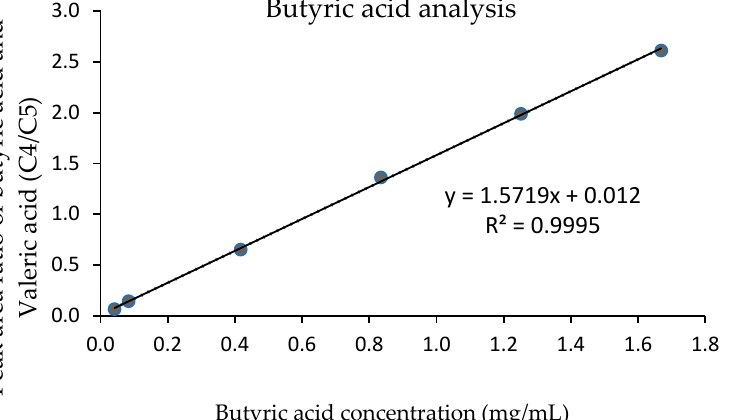
Figure 2. The standard calibration graph shows the relationship between the peak area ratio of butyric acid and valeric acid and the butyric acid concentration.